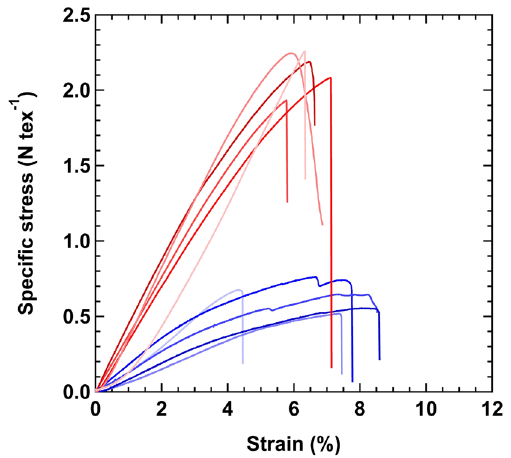
Figure 7. Stress–strain curves of as-made CNT fiber (blue curves) and CSA-CNT fiber (red